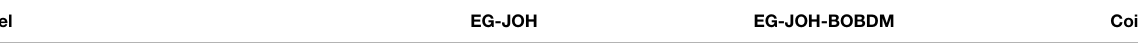
TABLE 3 | Bayer-Hanck cointegration test.